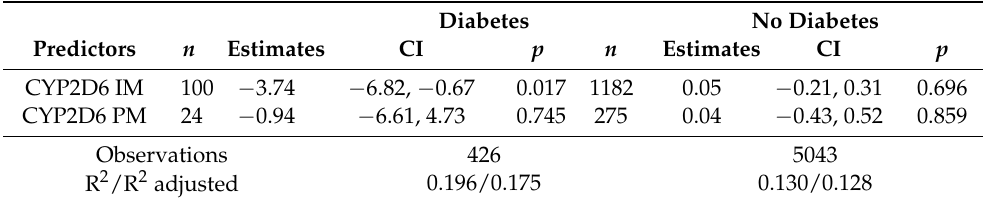
Table 4. Stratified analysis of diabetes status among participants taking fluoxetine. Model adjusted by age, ethnicity, sex, Table 2. D6, taking antidiabetics and BMI; Normal metabolizers of CYP2D6: diabetes = 302.